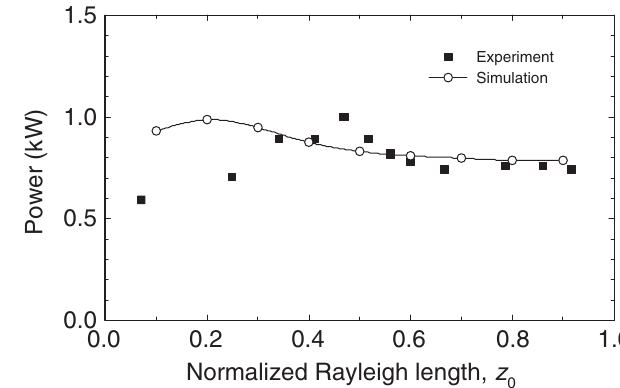
FIG. 4. Dependence of output power in a macropulse on z 0